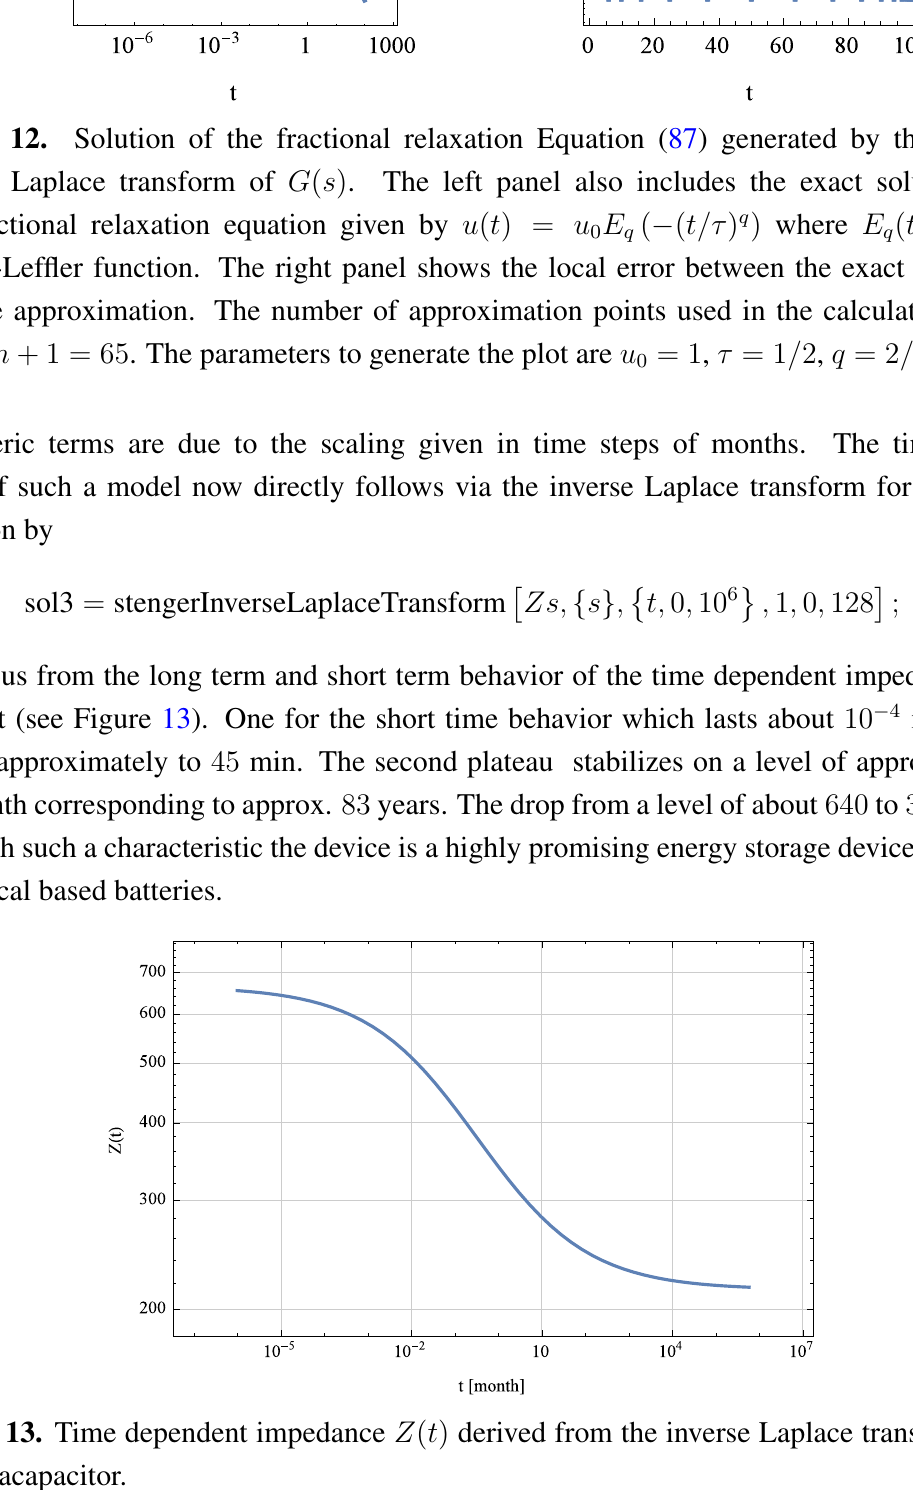
E ( (cid:0) ( t=(cid:28) ) q ) where E ( t ) is the 0 q q = 1 , (cid:28) = 1 = 2 , q = 2 = 7 . 0